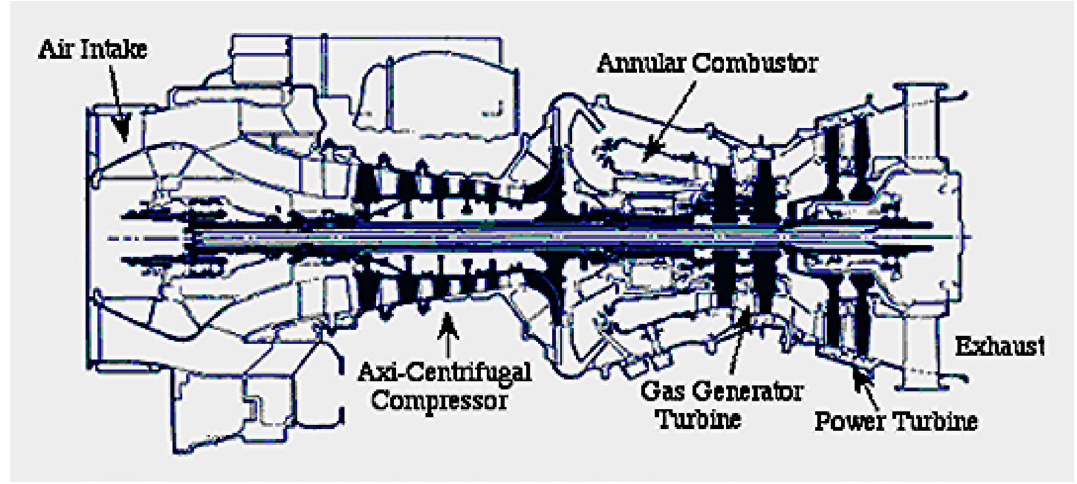
Fig. 2 Gas turbine cross section